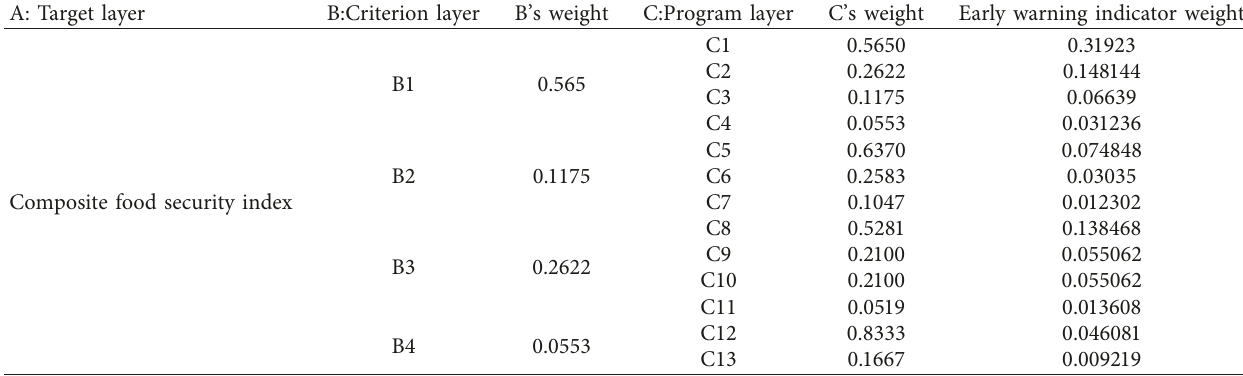
Table 3: Subjective weights of early warning indicators based on AHP method.